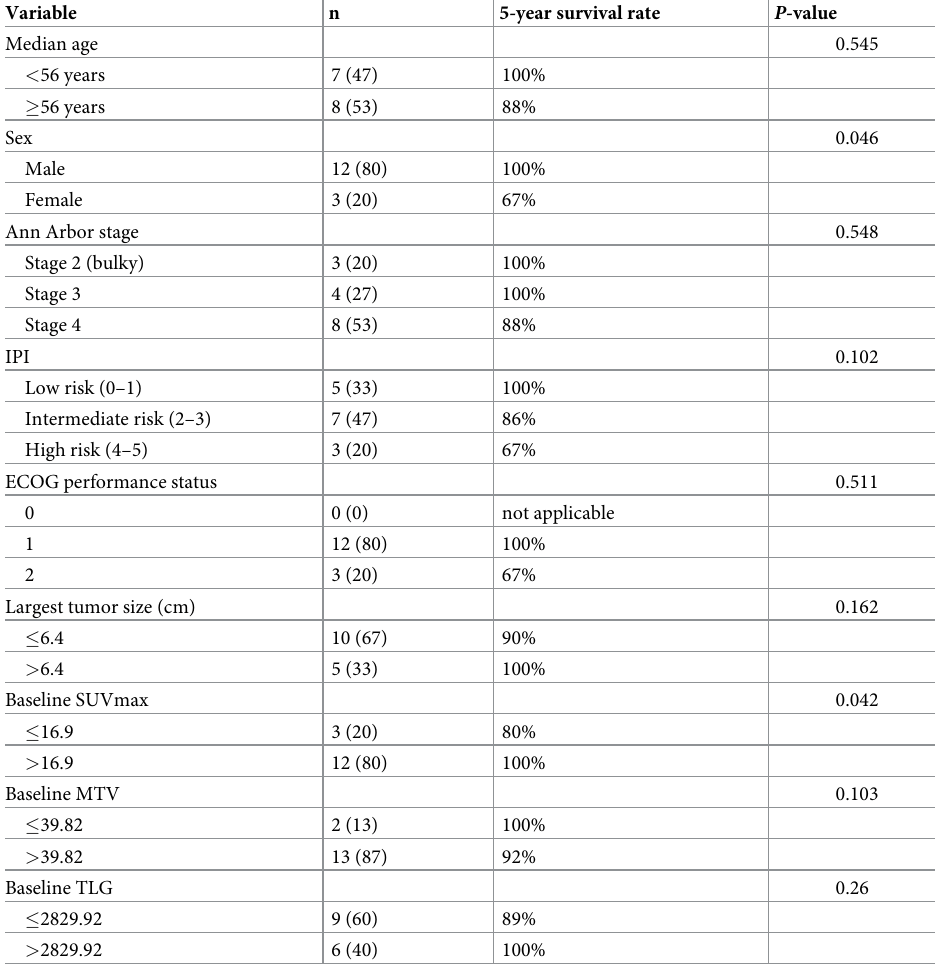
Table 3. Results of univariate Kaplan-Meier survival analysis for overall